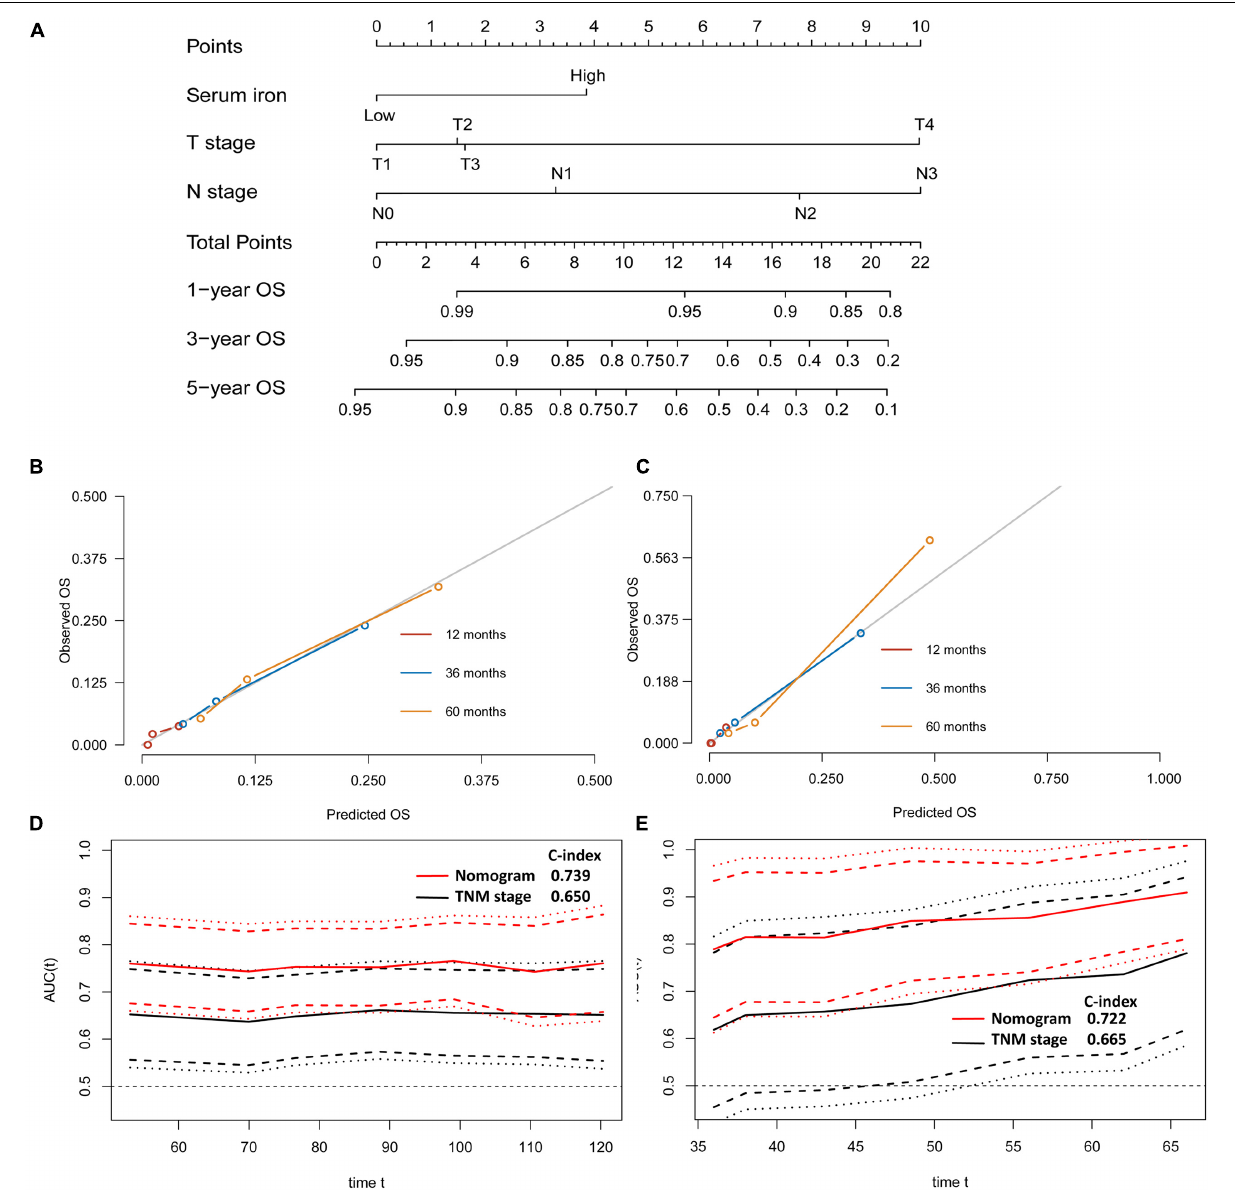
FIGURE 5 | Establishment and validation of a model for individualized prediction of overall survival (OS). (A) Nomogram of this predictive model for patients with early-stage triple-negative breast cancer. (B) Calibration plots for predicting OS at 1 − , 3 − , and 5-year in the training cohort. (C) Calibration plots for predicting OS at 1 − , 3 − , and 5-year in the SYSUCC-001 validation cohort. (D) Time-dependent receiver operating characteristic (ROC) curves in the training cohort. (E) Time-dependent ROC curves in the SYSUCC-001